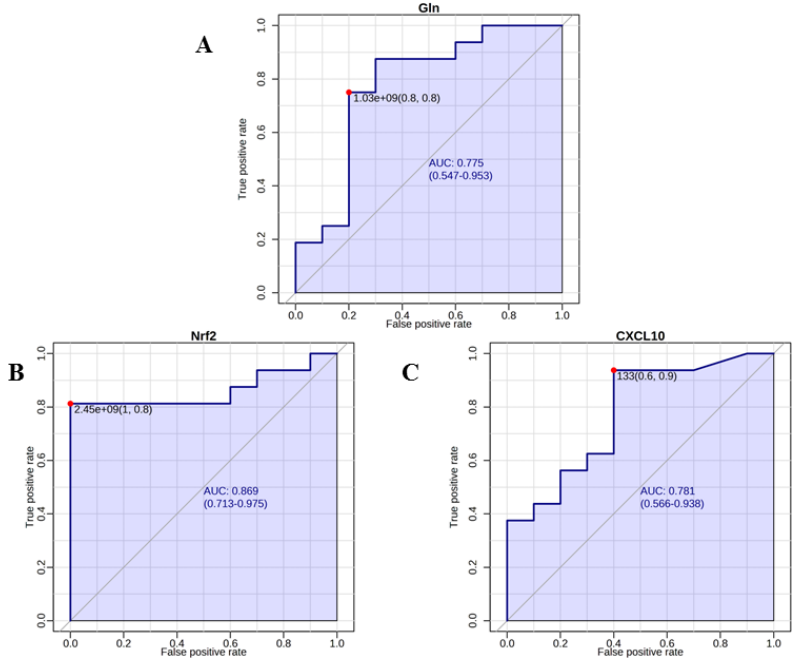
Figure 5. ROC curves for glutamine (A), and the 2 proteins or Nrf2 (B) and CXCL10 (C) with